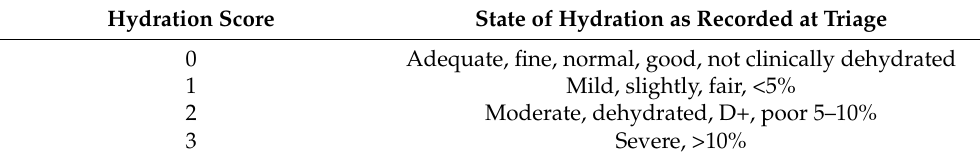
Table 2. Hydration status of koalas based on descriptions recorded at